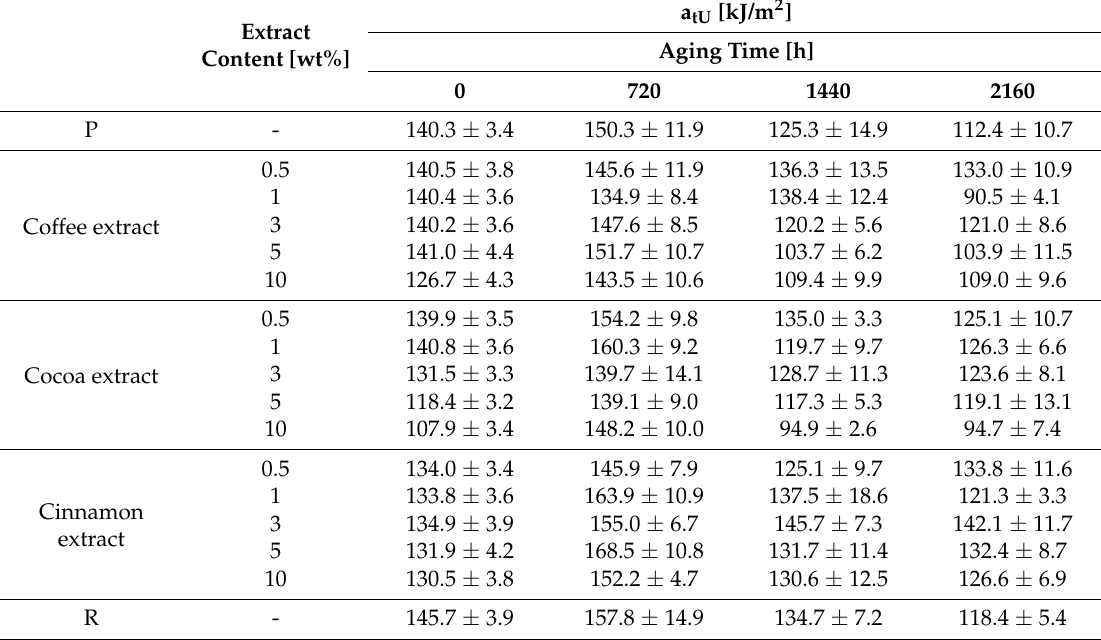
Table 5. Results of impact tensile strength (a tU ) test.